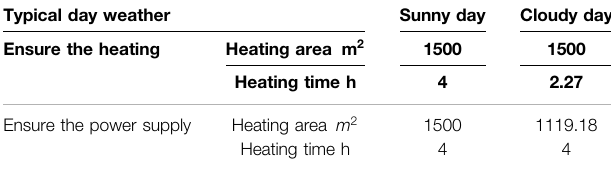
TABLE 6 | The situation of power supply and heating on different typical